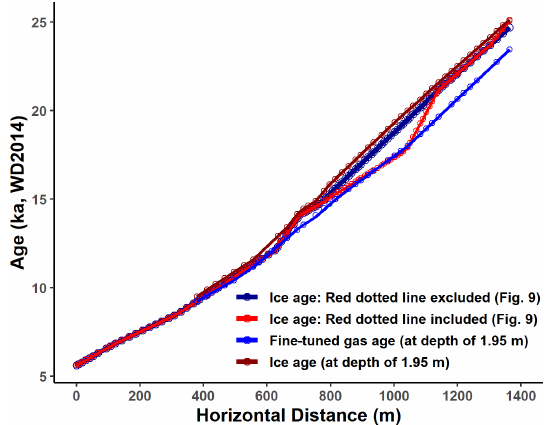
Figure C3. Relation between horizontal distance and